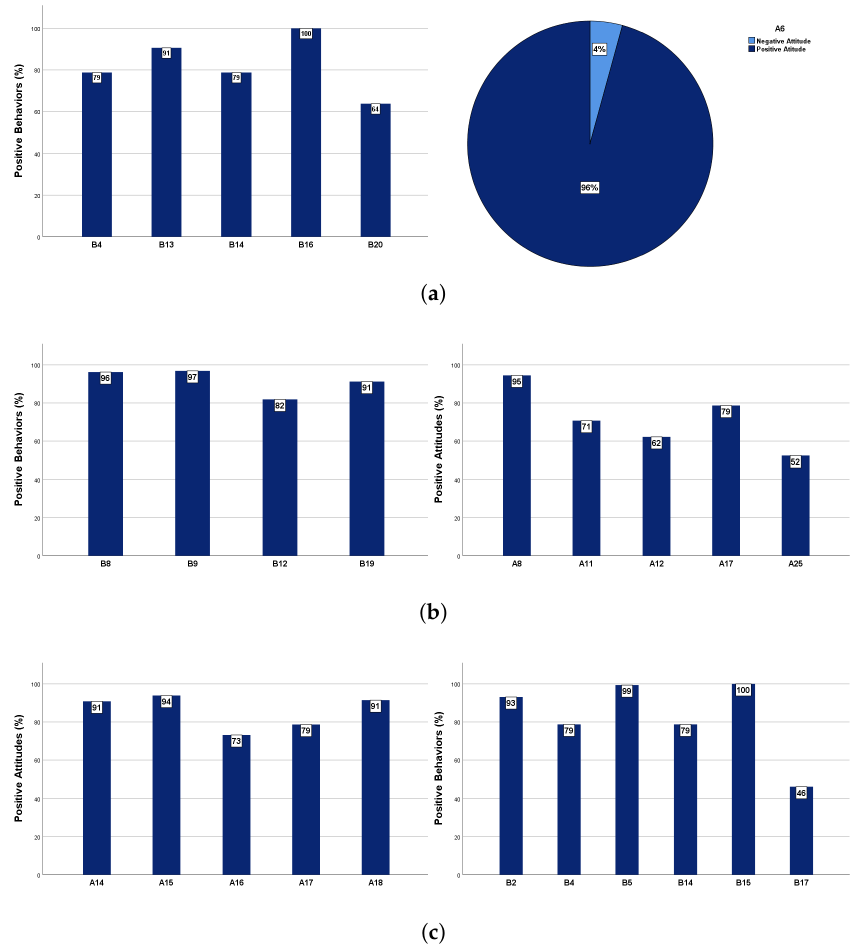
Figure 6. Findings: Attitudes and behaviors. ( a ) Finding 01—attitudes and behaviors. ( b ) Finding 02—attitudes and behaviors. ( c ) Findings 03 and 04—attitudes and